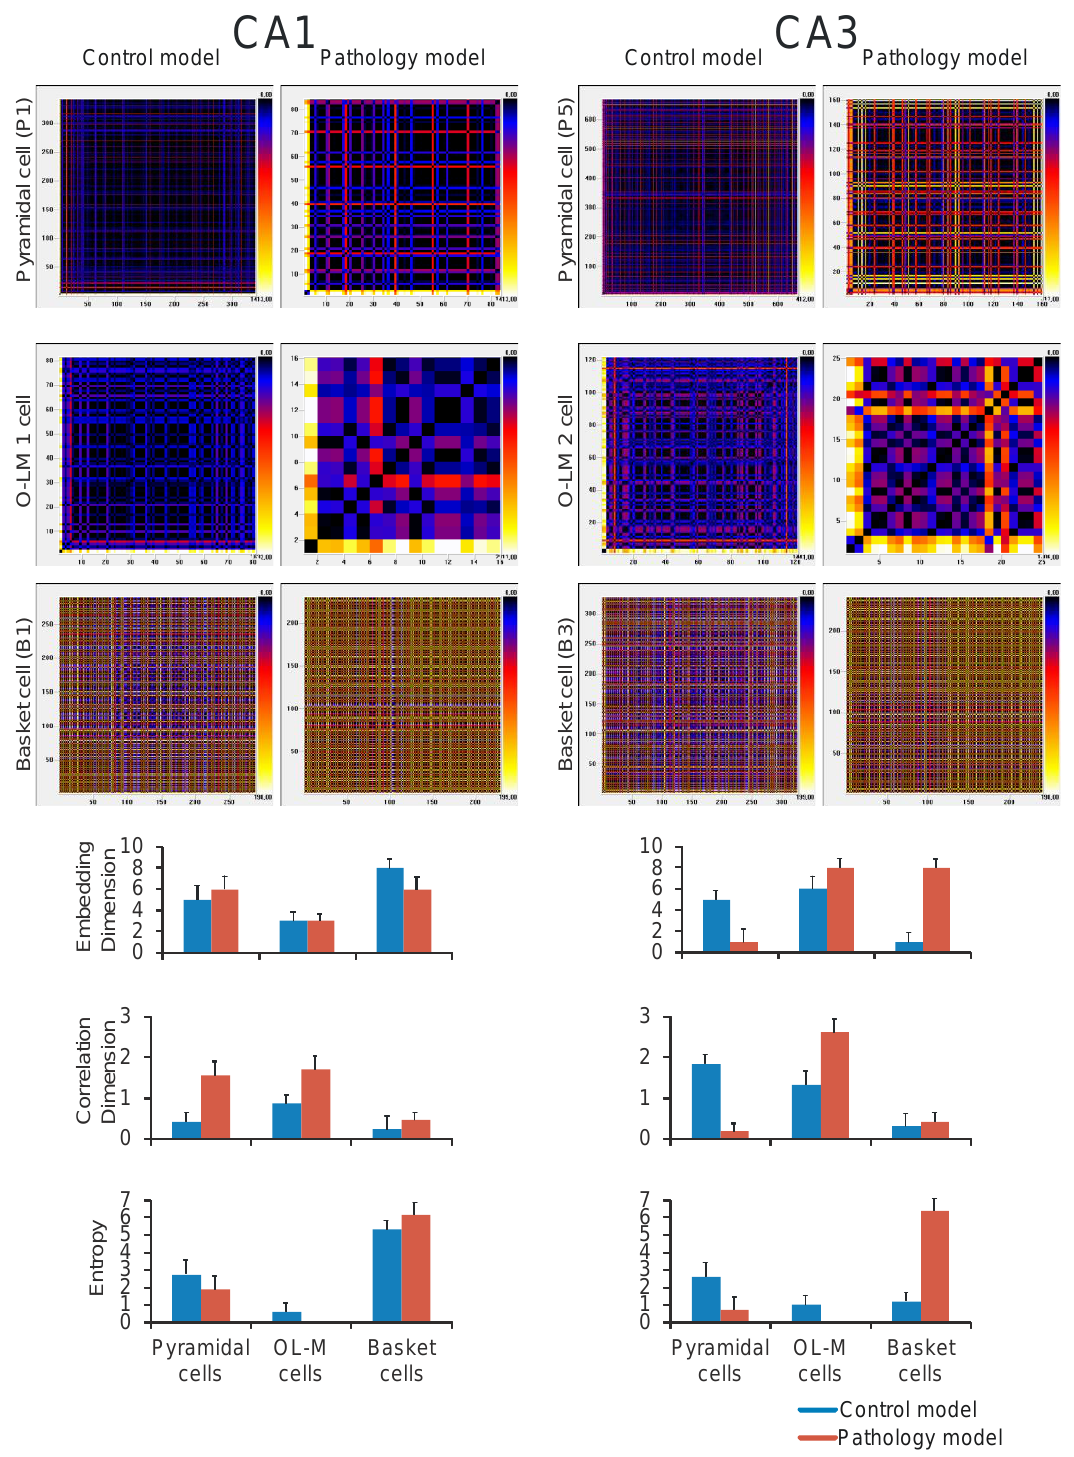
Figure 7. Nonlinear analysis of simulations CA1 region (left) and CA3 (right). On the top recurrence plots with visual recurrence analysis (VRA), which shows all Euclidean distances between data points from the 3-dimensional phase space for all cell types (pyramidal, OL-M and basket). On the bottom: comparison of control and pathology models embedding dimension, correlation dimension, entropy for pyramidal (P1 and P5), OL-M (1 and 2) and basket cells (B1 and B3).